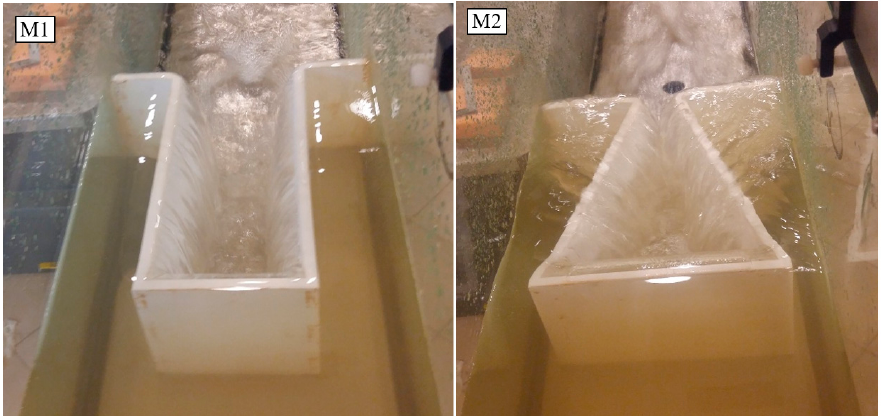
Figure 13. Flow condition for M1 and M2 models; Q = 0.00375 m 3 /s for M1 model, and Q = 0.00365 m 3 /s for M2 model.